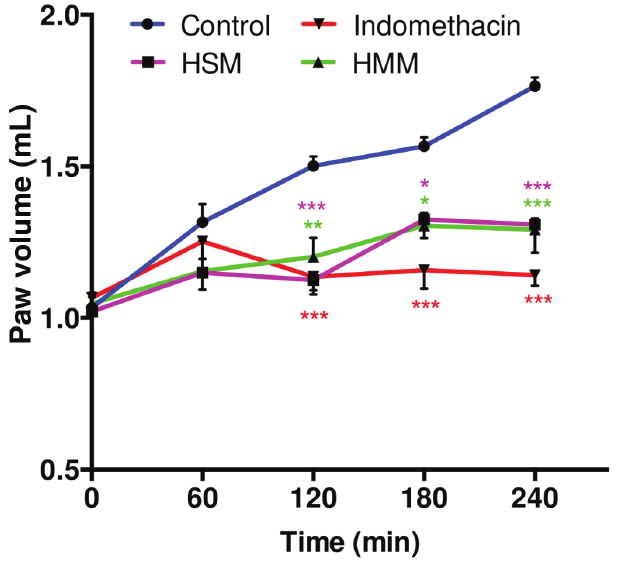
FIGURE 1 - Anti-inflammatory effect of Soxhlet methanol and maceration methanol extracts of plant on carrageenan-induced paw edema. Values are mean of triplicate determination and expresses as Mean ± SEM (Standard error mean); values are calculated using two-way ANOVA followed by Tukey posttests; *** p <0.001, ** p <0.01 and * p <0.05 when compared to control group; n=6. HSM: Soxhlet methanol extract; HMM: maceration methanol